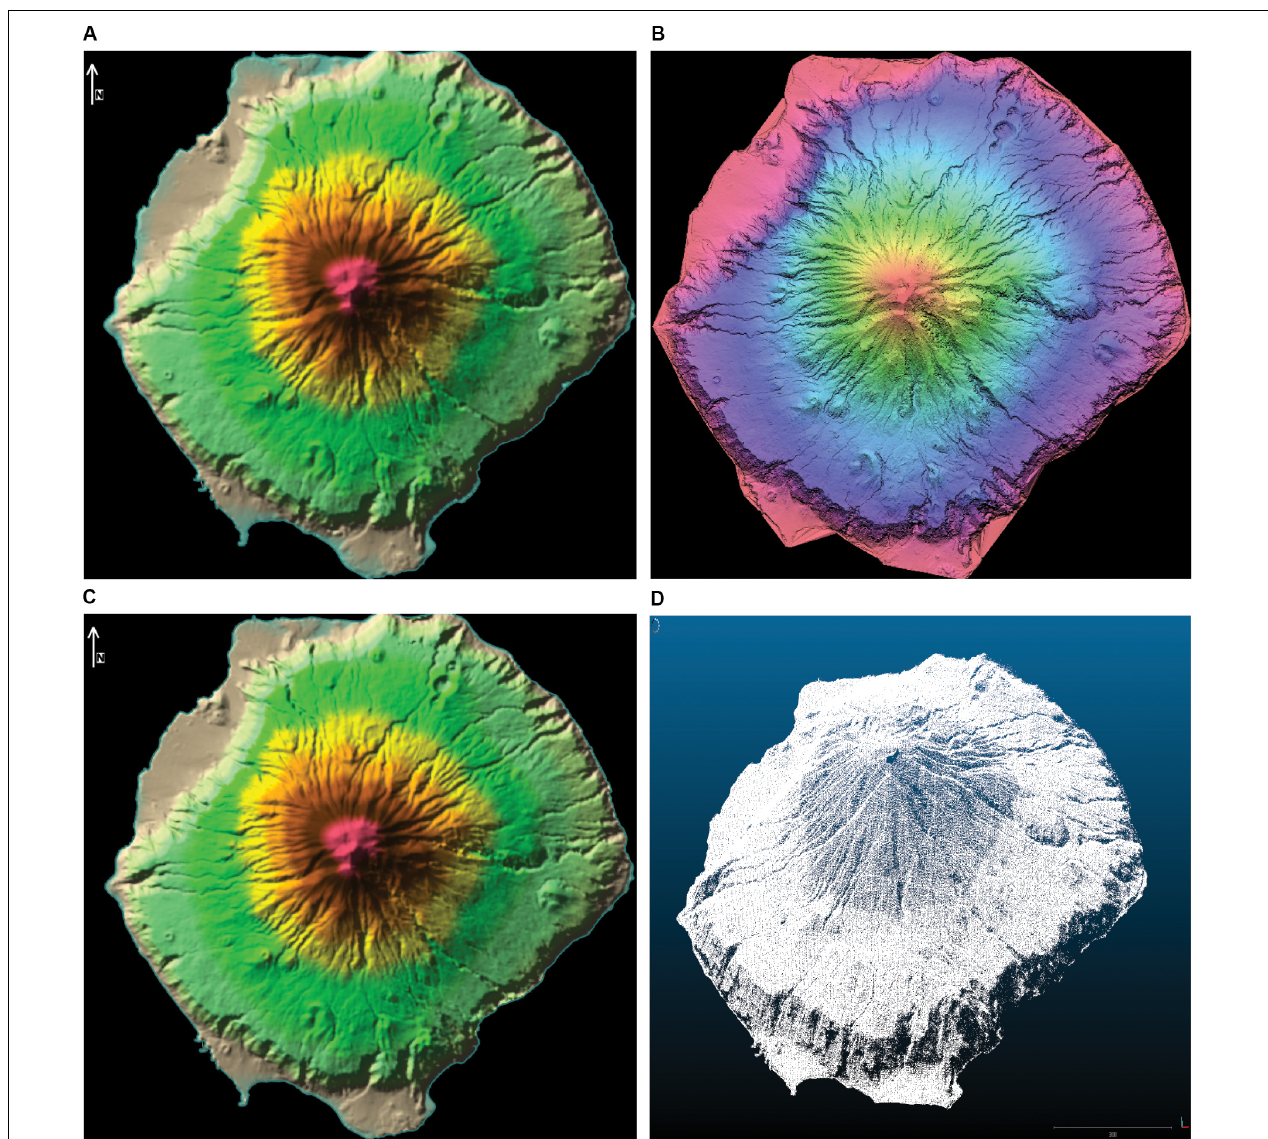
FIGURE 8 | Raster DEM with 2m GSD generated with (A) BAE SocetGXP ATE, (B) Erdas Imagine eATE, (C) PCI Geomatica Orthoengine. (D) Point cloud generated by Erdas SGM with approx. 1 m point sampling